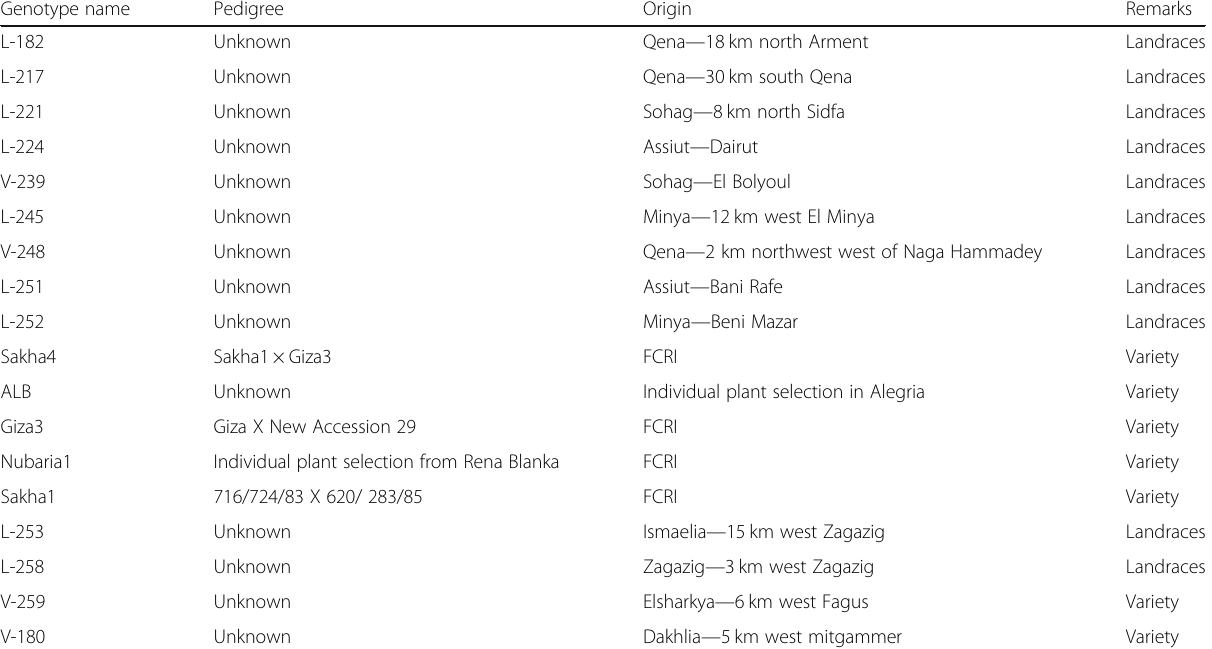
Table 1 Origins of the faba bean